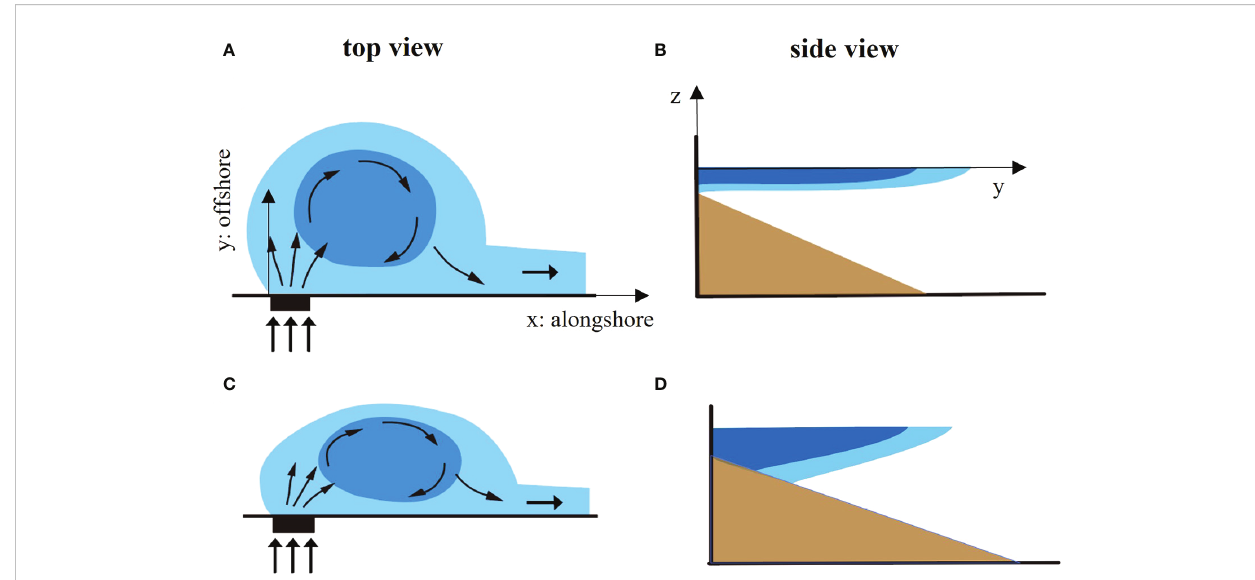
FIGURE 1 Schematic of a surface-advected plume ( A : top view and B : side view) and a bottom-attached plume ( C : top view and D : side